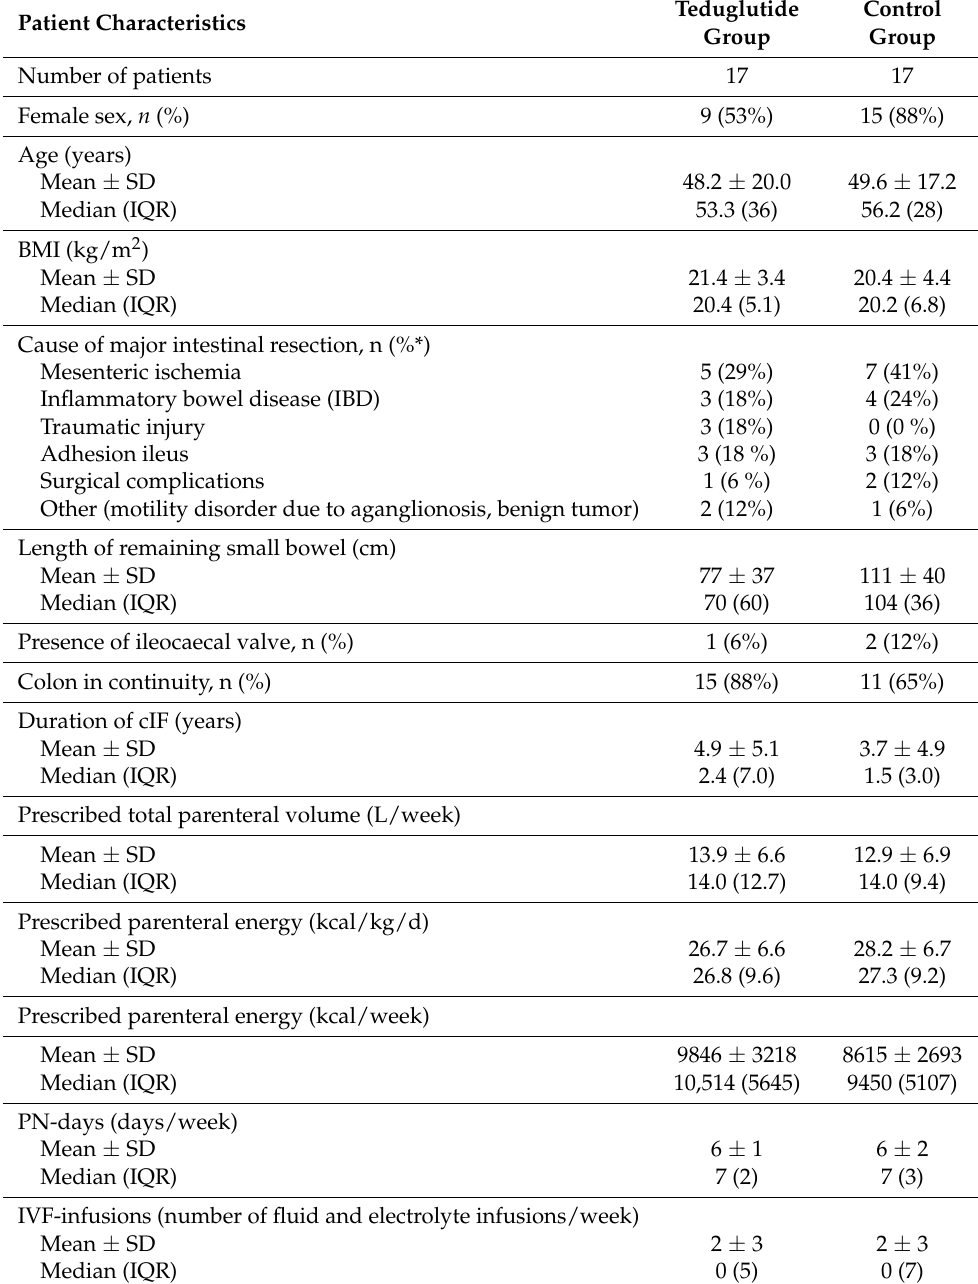
Table 1. Patient characteristics for teduglutide and control